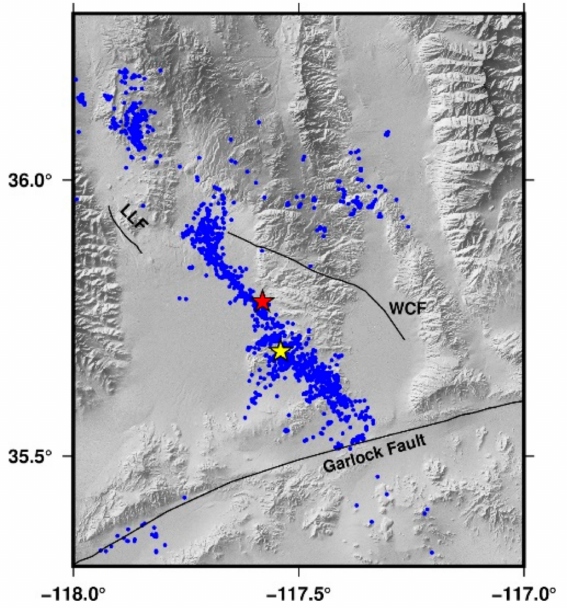
Figure 6. Mw 7.1 earthquake aftershock distribution. Red star is mainshock. Yellow star is foreshock. Blue dots indicate aftershocks of Mw > 2 (from 28 July 2019, to 15 August